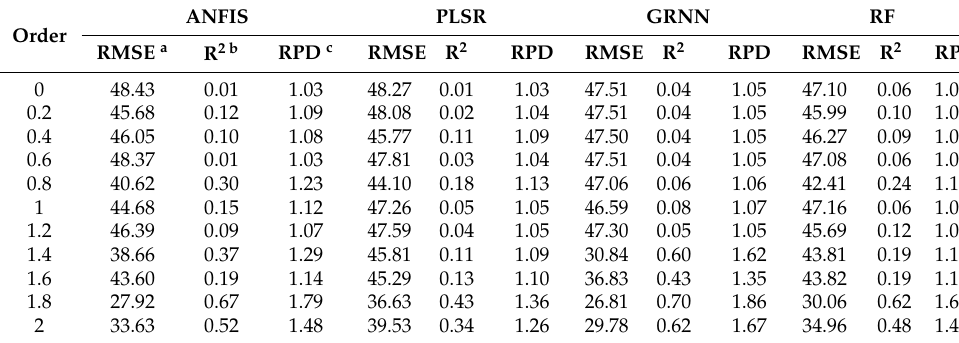
Table 5. Estimation model accuracy of Hg.